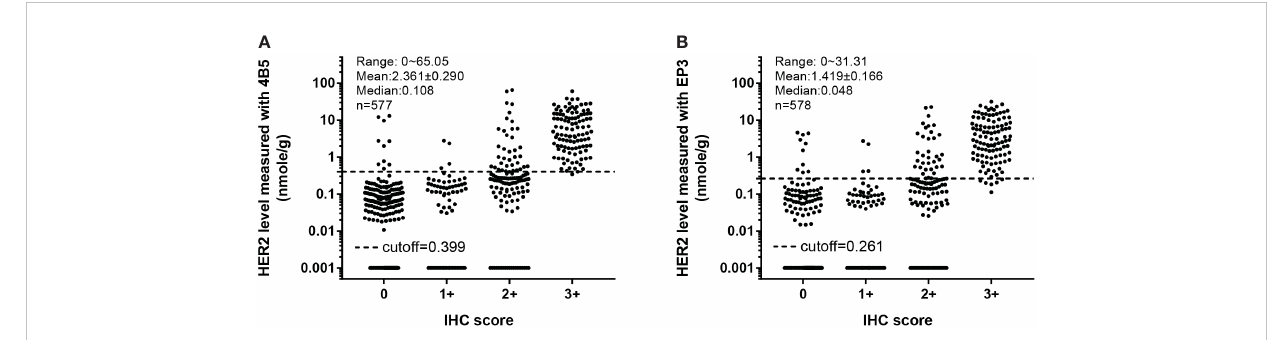
FIGURE 4 Overall distribution of absolutely quantitated HER2 levels in the merged cohort within each IHC category. The Her2 protein levels in both cohort 1 and cohort 2 were measured with the QDB method using EP3 and 4B5 antibodies, respectively, and plotted together against their respective IHC scores. (A) In QDB analysis with the 4B5 antibody, Her2 levels ranged from 0 to 65.05 nmol/g, with a mean of 2.361 ± 0.290 and a median of 0.108, n = 577. (B) For those with the EP3 antibody, its levels ranged from 0 to 31.31 nmol/g, with a mean of 1.419 ± 0.166 and a median of 0.048, n =